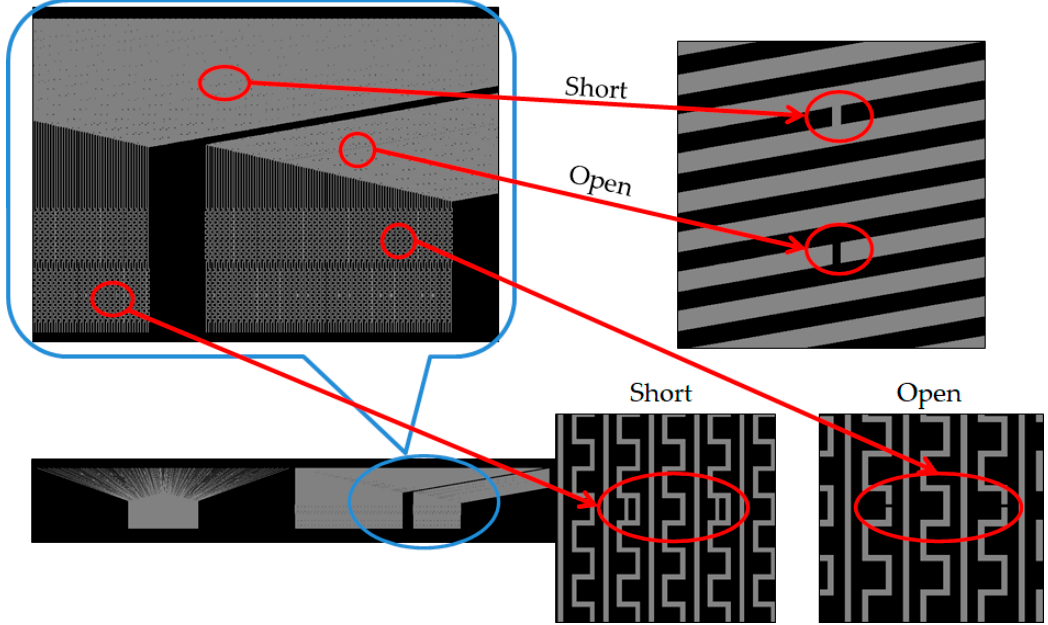
Figure 13. Illustration of line scan at open and short defects along with the peripheral right site of the photomask.